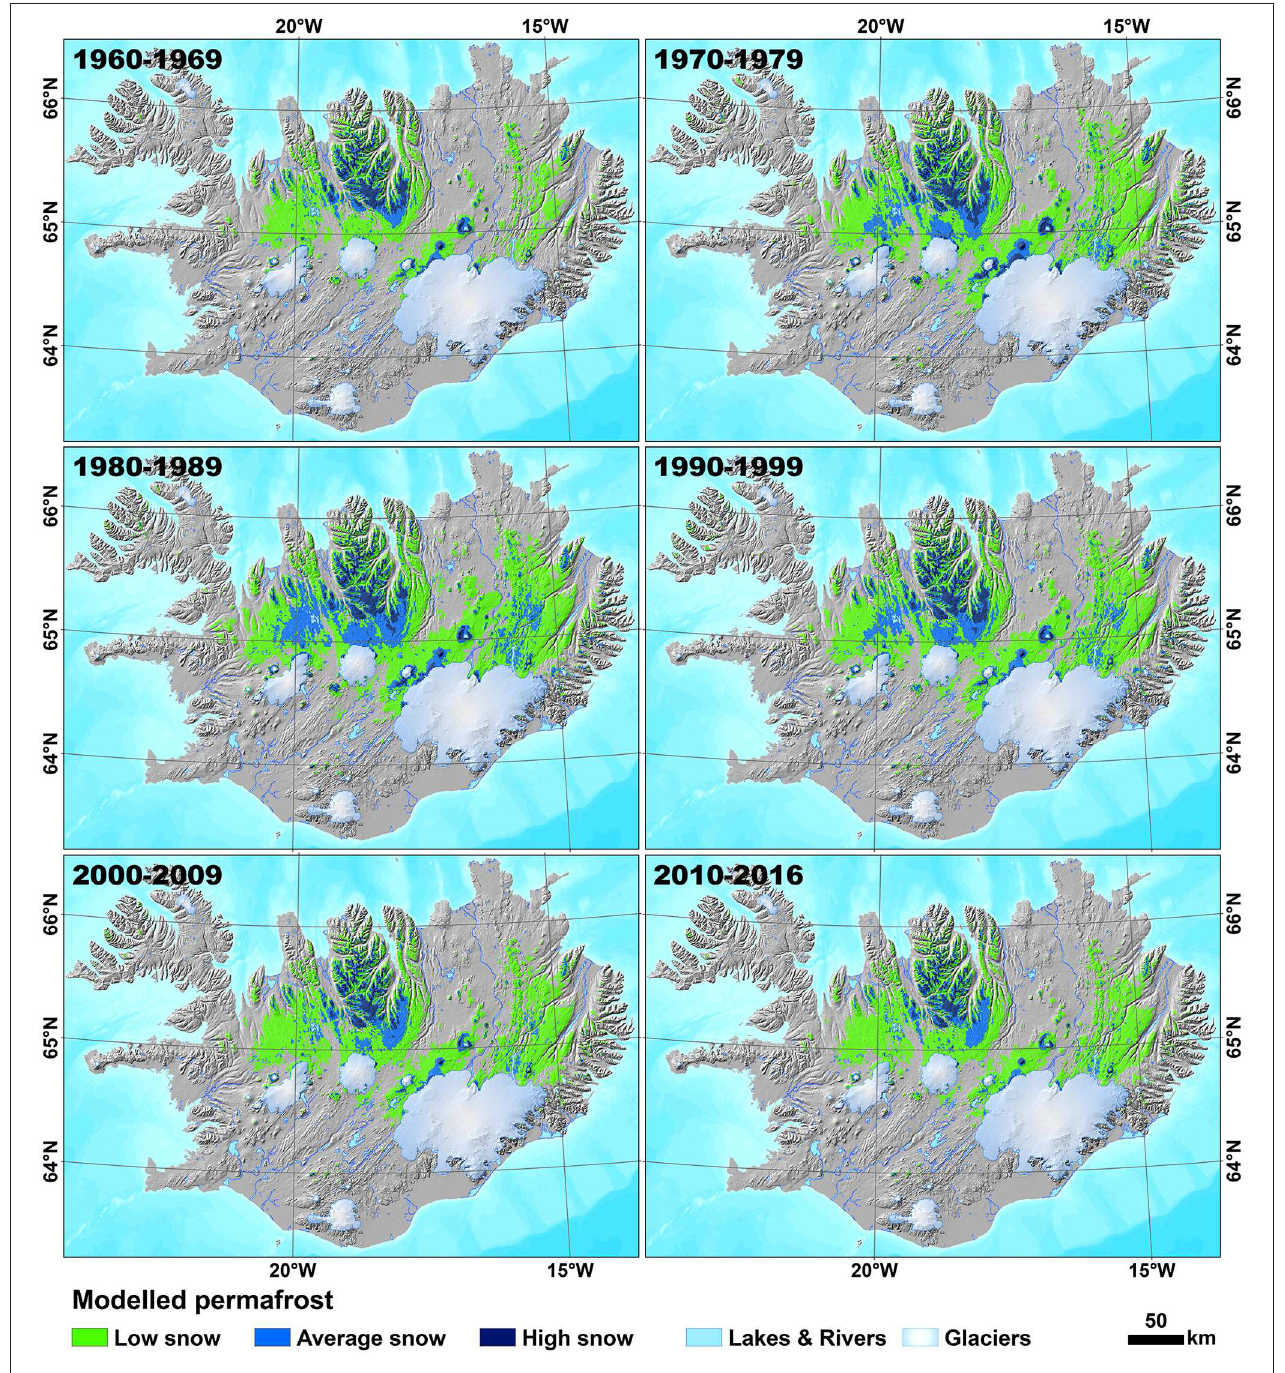
FIGURE 9 | Spatio-temporal evolution of the modelled permafrost extent based on TTOP at or below 0 ◦ C in 10 consecutive years for the three snow depth scenarios: “Low snow” represents permafrost reproduced in 50% precipitation scenario, “Average snow” represents permafrost reproduced in 50 and 100% precipitation scenarios, and “High snow” represents permafrost reproduced in all precipitation scenarios. Map data from NLSI.